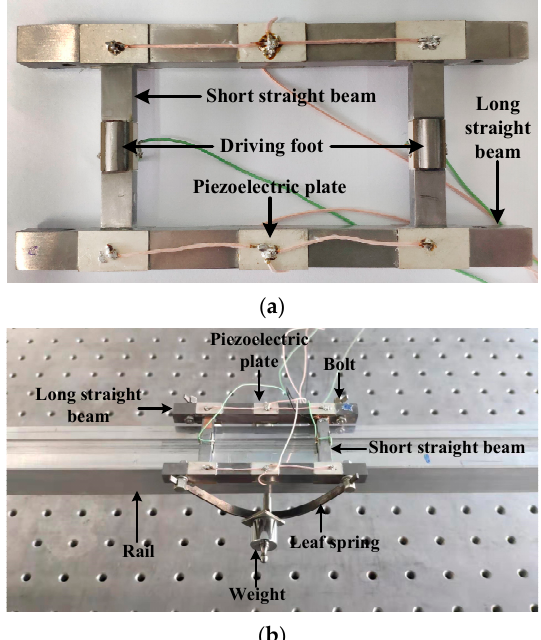
Figure 7. The prototypes of ( a ) the framed piezoelectric actuator and ( b ) the assembled piezoelectric carrier robot.